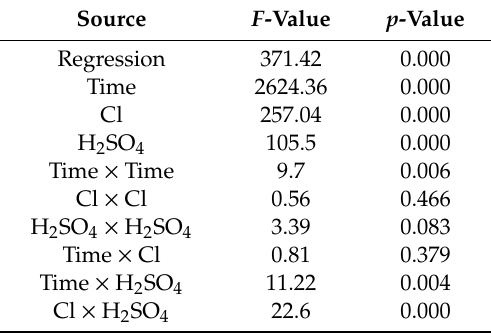
Table 5. ANOVA Cu